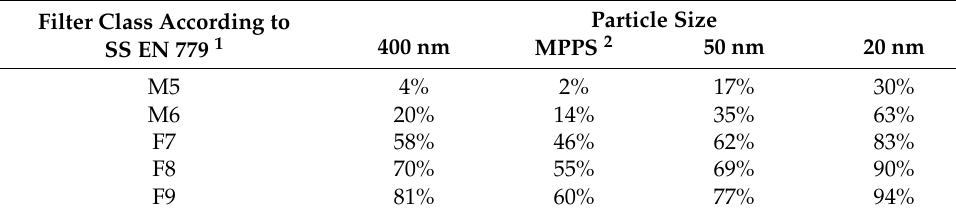
Table 1. The degree of separation in percent for different filters at different particle sizes